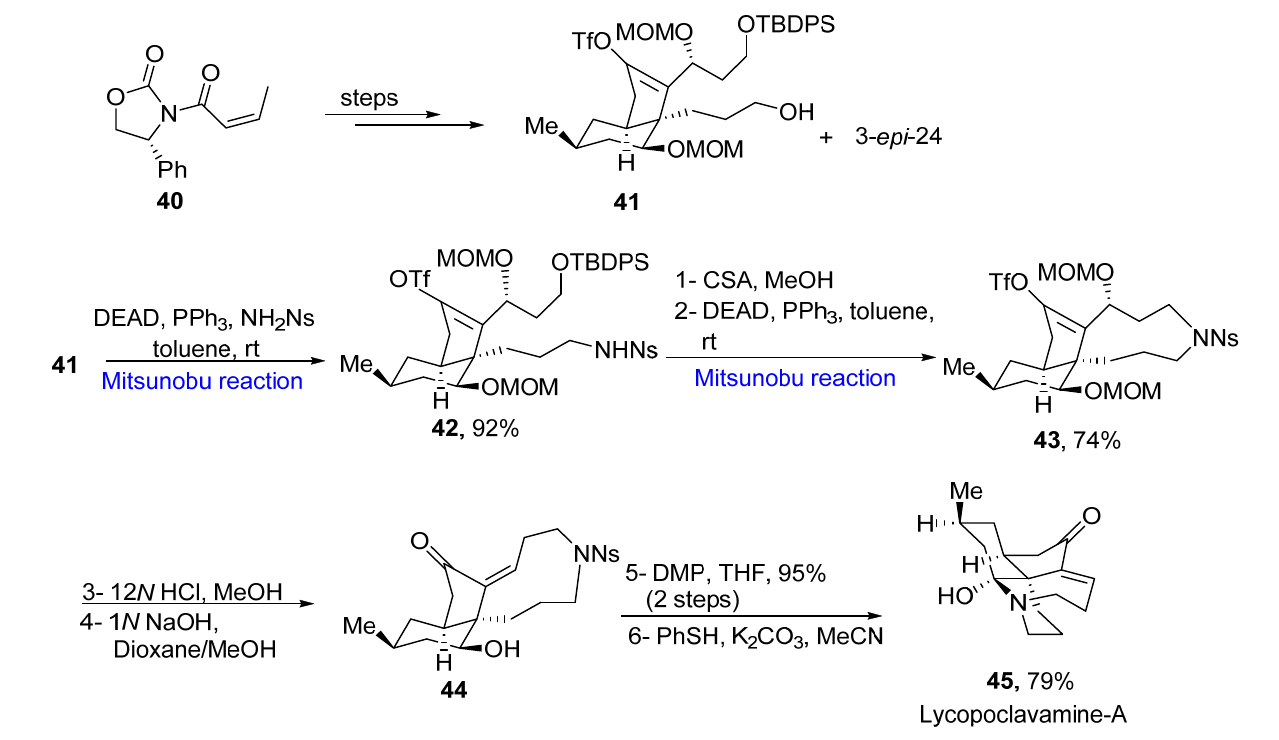
Scheme 7. Total synthesis of lycopoclavamine A alkaloid 45 .